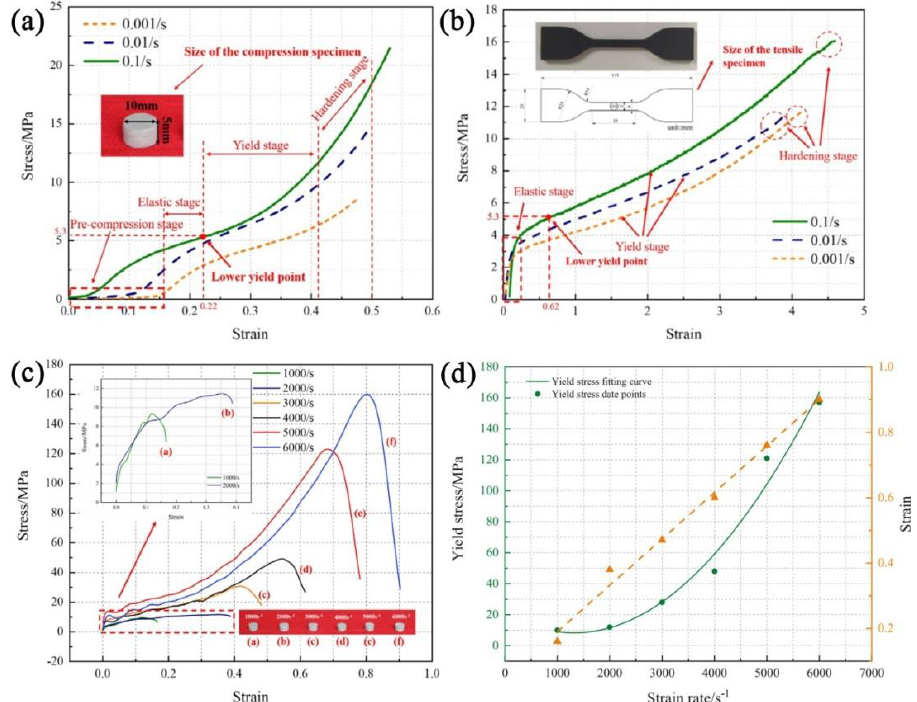
Figure 8. Mechanical performance of AP103-type polyurea: ( a ) quasi-static compression, ( b ) quasi-static tensile, ( c ) dynamic compression and ( d ) corresponding yield stress and strain. Reproduced with permission from ref. [16].